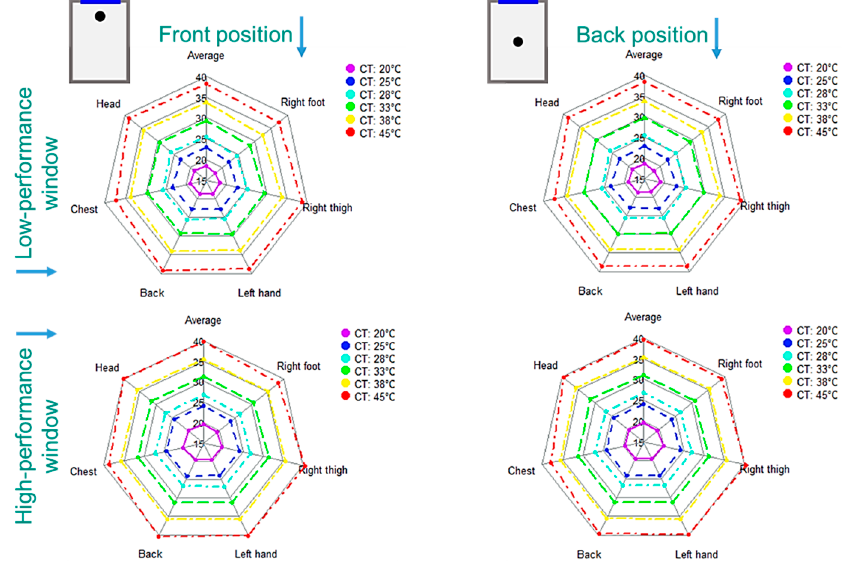
Figure 12. Air temperatures at selected body-limb locations in the middle room with one façade influenced by ceiling temperatures, quality of facades, and the position of the manikin.